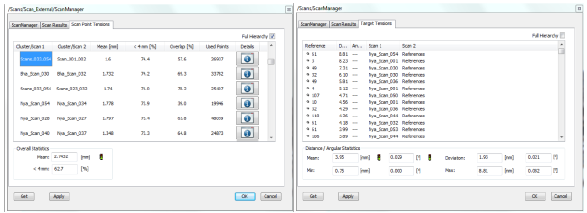
Figure 3. Accuracy of the point cloud